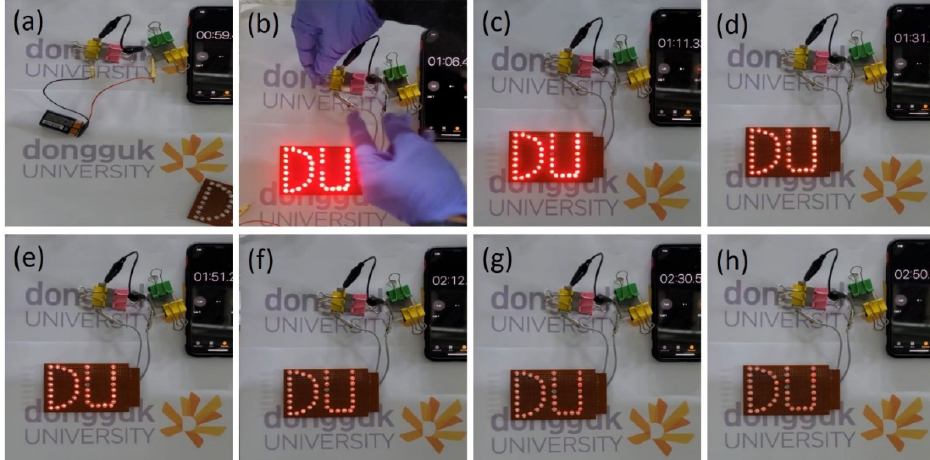
Figure 9. (a–h) . Commercial practical demonstration of the LED with different discharging times. Figure 9. ( a – h ). Commercial practical demonstration of the LED with different discharging